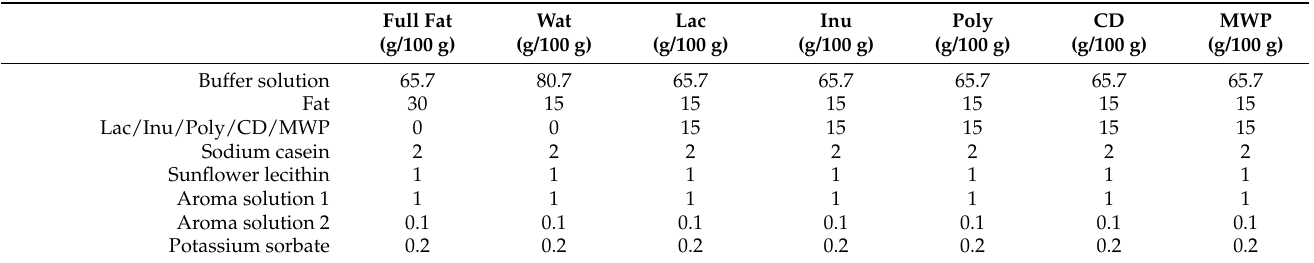
Table 1. Formulations of the emulsions (Wat = water, Lac = lactose, Inu = inulin, Poly = polydextrose, CD = corn dextrin, MWP = microparticulated whey protein).